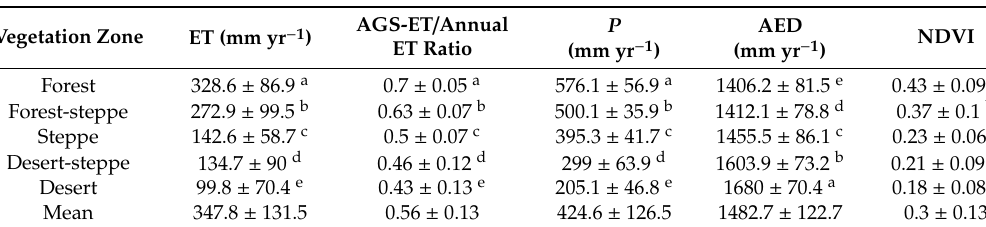
Table 1. Statistical characteristics of ET and AGS-ET / Annual ET ratio for di ff erent vegetation zones averaged over 2000–2014 in the Chinese Loess Plateau. The P , AED, and NDVI values are also provided for reference. Di ff erent superscript letters denote a statistically significant di ff erence at a 5% confident level based on Tukey’s multiple comparison tests.